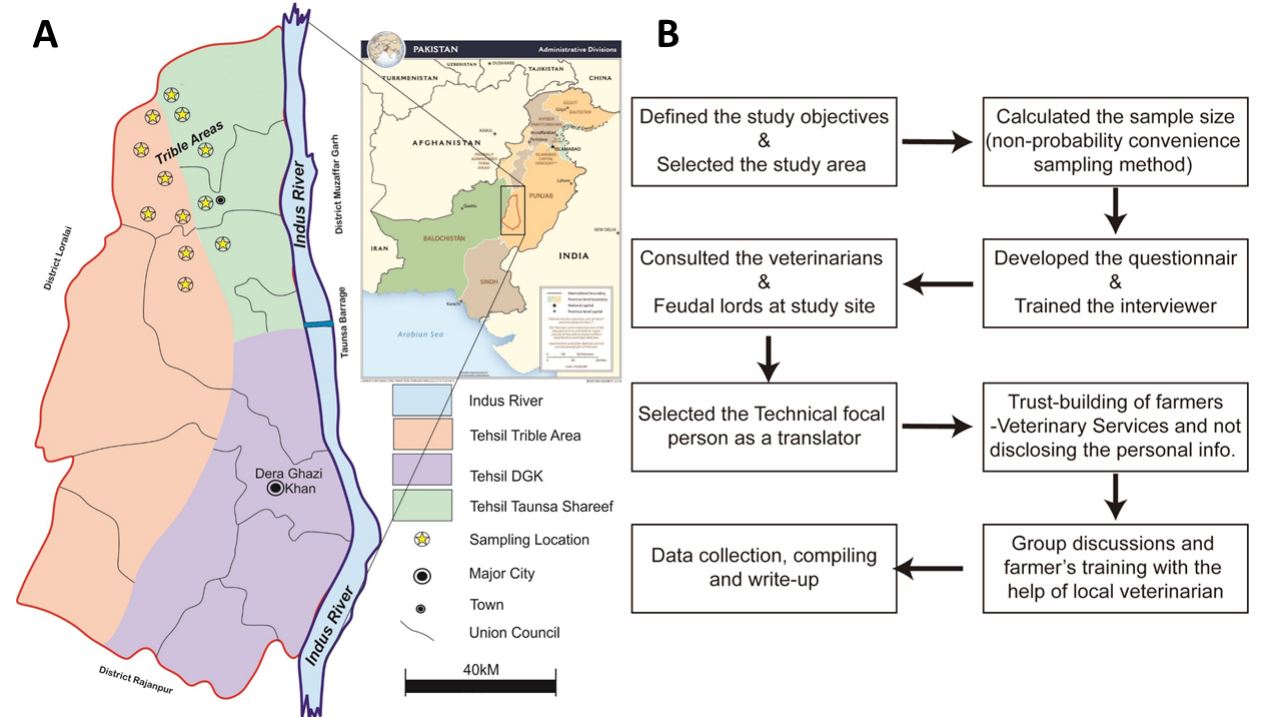
Figure 1. Sampling area ( A ) and survey building steps ( B ).